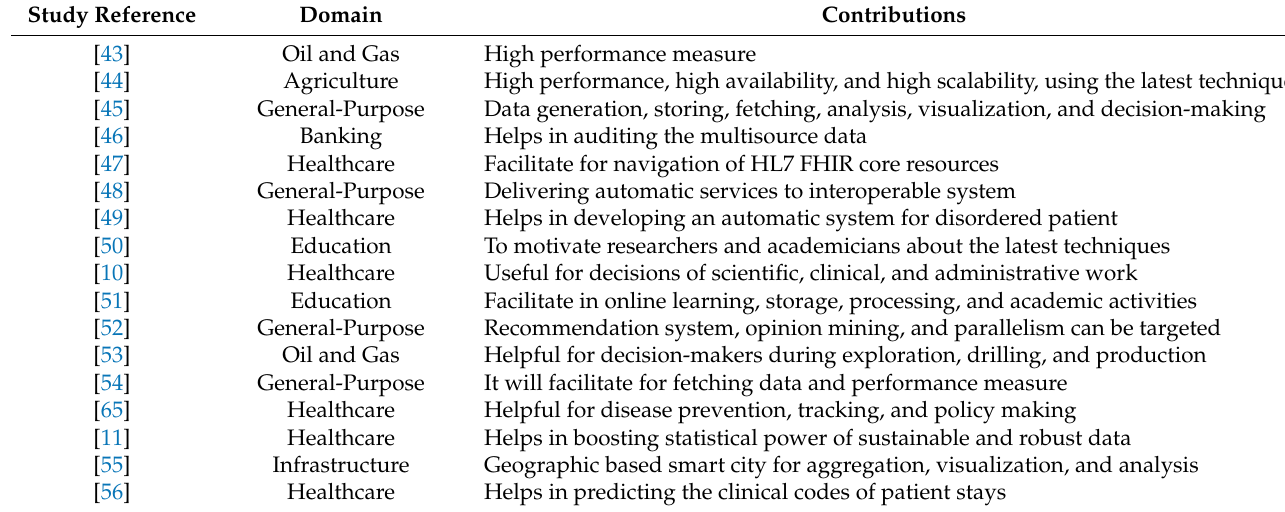
Table 7. RQ2 domain and